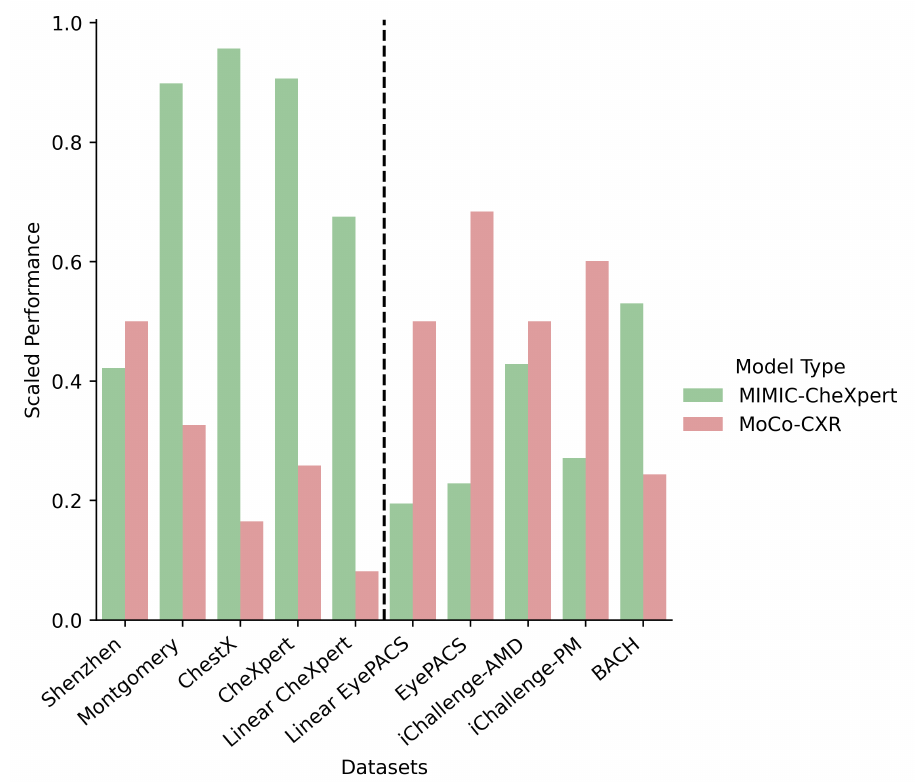
Figure 5. Bar chart of model transfer performance on different downstream tasks for the MIMIC- CheXpert (green) and MoCo-CXR (red) models. Results are scaled between 0 and 1. All in-domain datasets are located to the left of the dotted